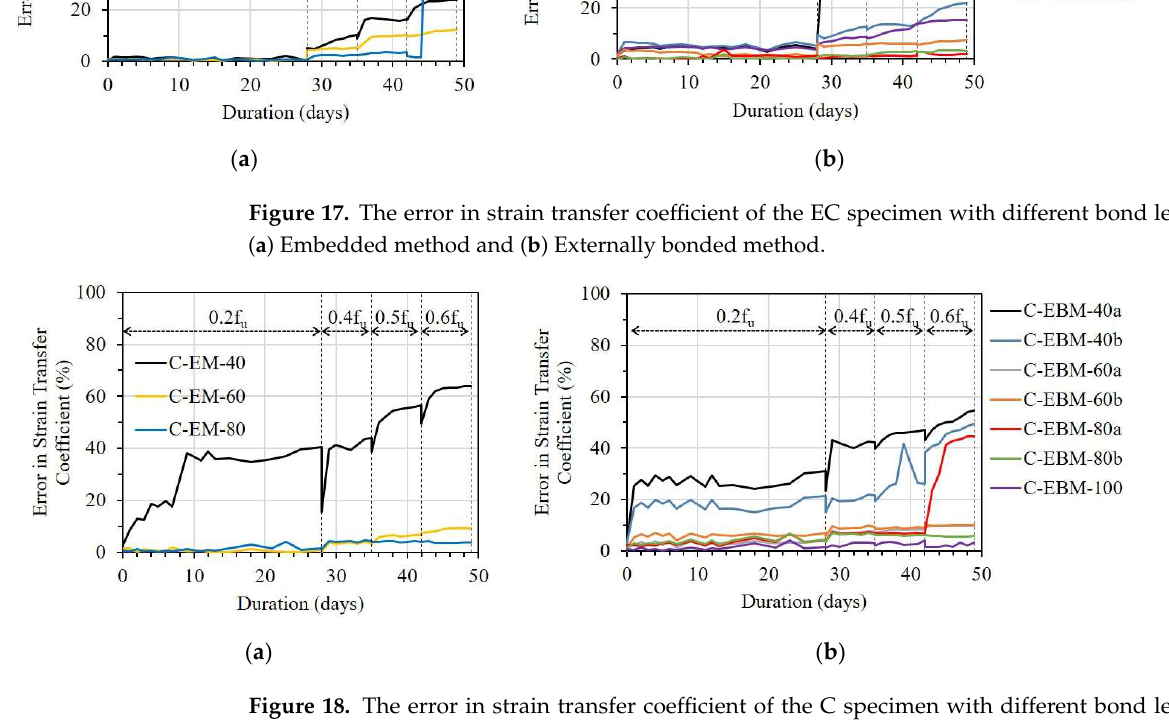
( b ) Figure 18. The error in strain transfer coefficient of the C specimen with different bond lengths: ( a ) Embedded method and ( b ) Externally bonded method.